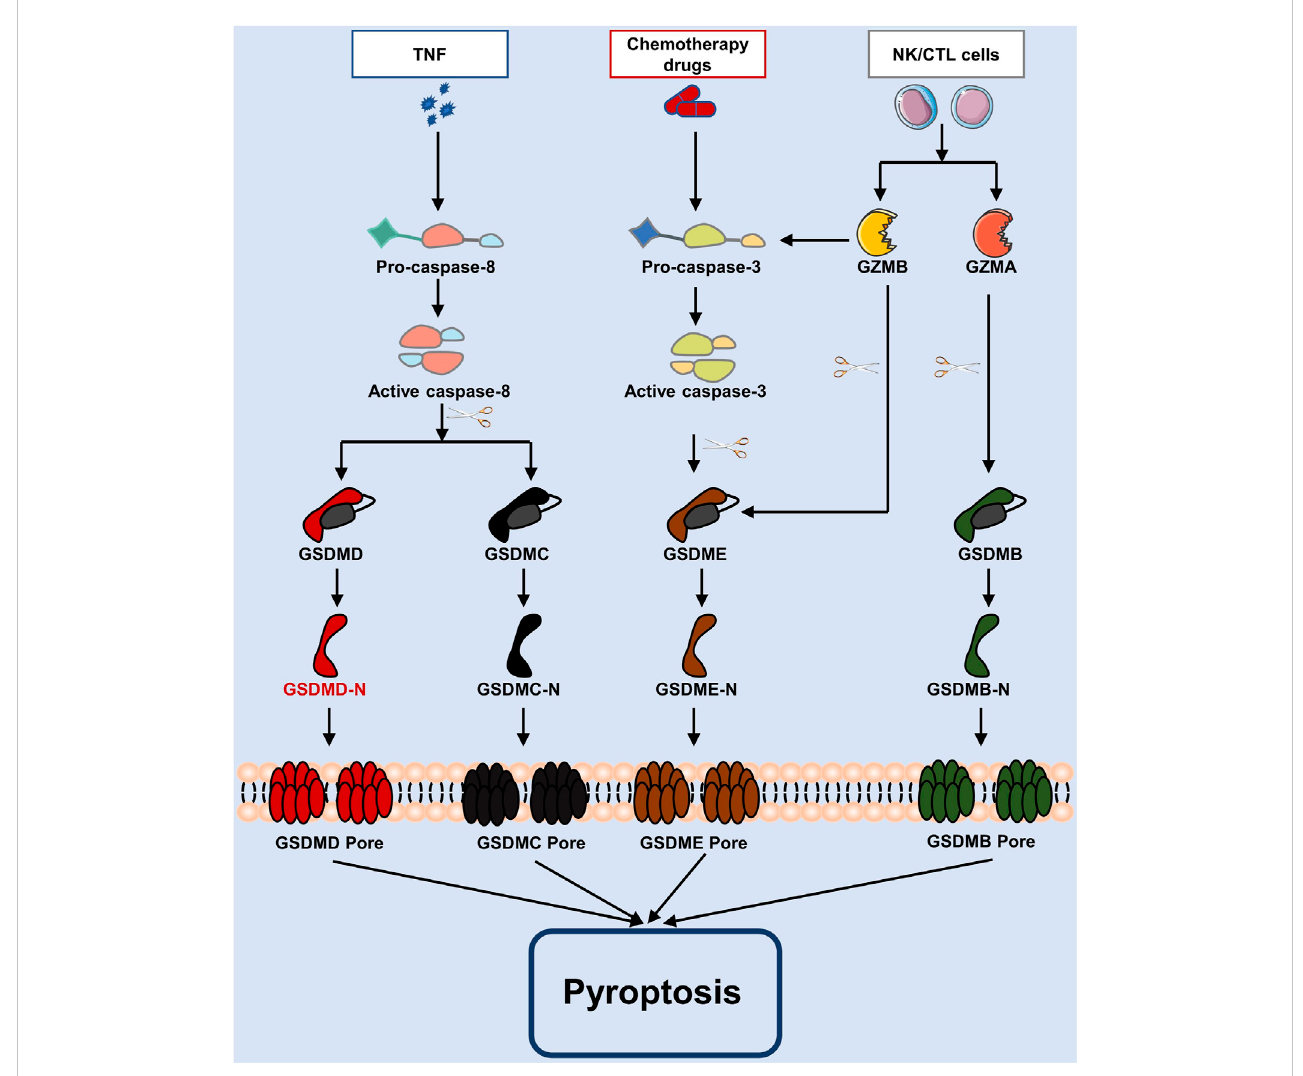
FIGURE 2 The apoptotic caspase and granzymes-mediated pyroptosis process. Caspase-3 and caspase-8 are activated in pyroptosis by chemotherapy drugs and TNF, whereas caspase-3/GSDME, caspase-8/GSDMD, caspase-8/GSDMC, etc., are involved pathways. As well, in cytotoxic lymphocytes, GZMA or GZMB are inserted via perforin, and GSDMB or GSDME are cleaved to cause